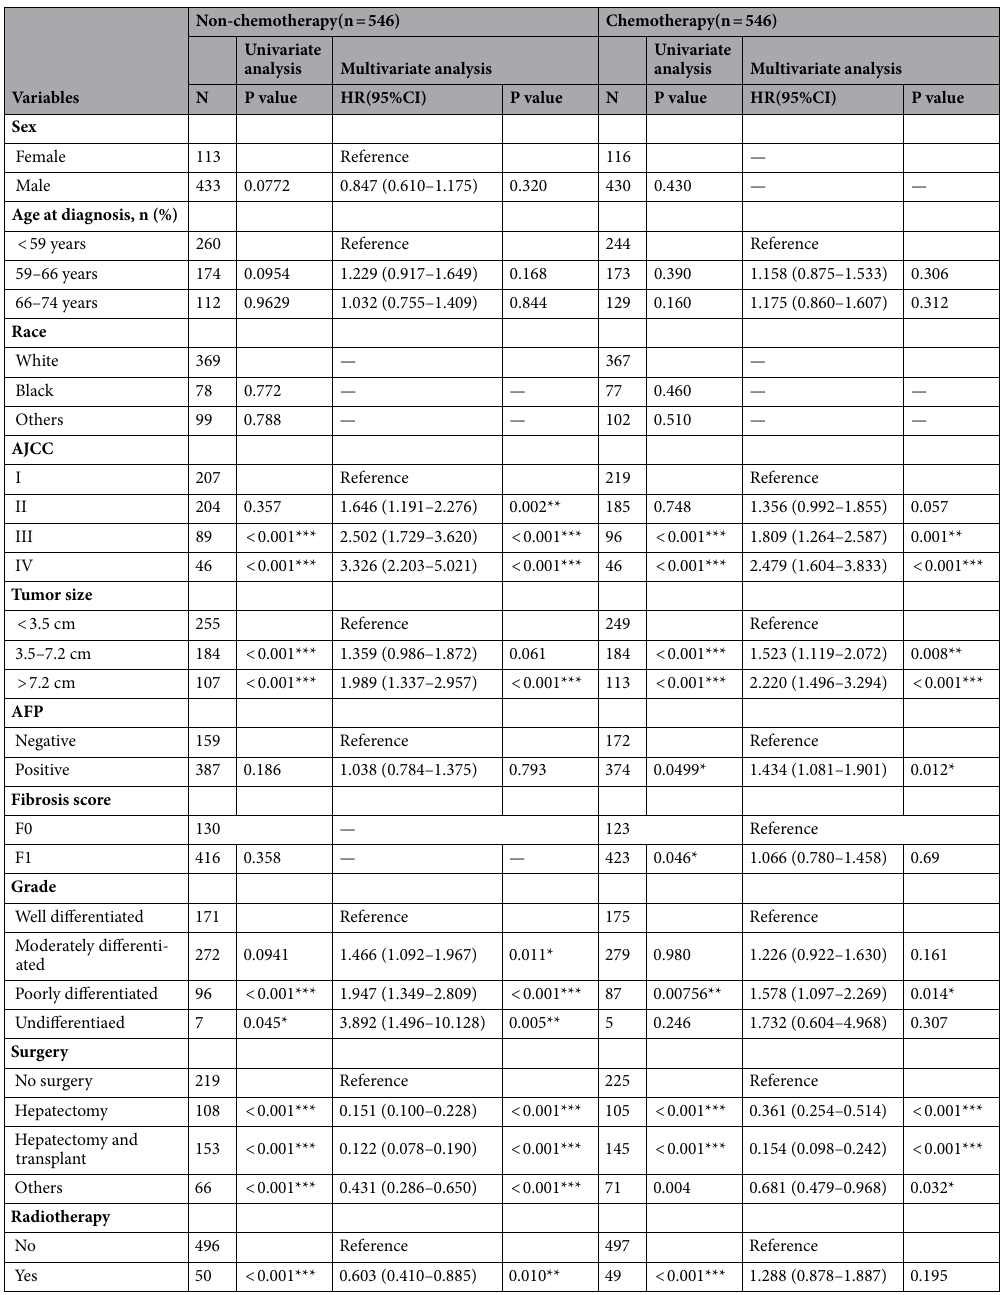
Table 2. Univariate and multivariate analysis of OS in the patients with chemotherapy and without chemotherapy. *Two-sided P values < 0.05. **Two-sided P values < 0.01. ***Two-sided P values < 0.001. OS, overall survival; HR, hazard ratio; CI, coindidence intervals; AJCC, American Joint Committee on Cancer (7th). F0, fibrosis score 0–4, non to moderate fibrosis; F1, fibrosis score 5–6, severe fibrosis and